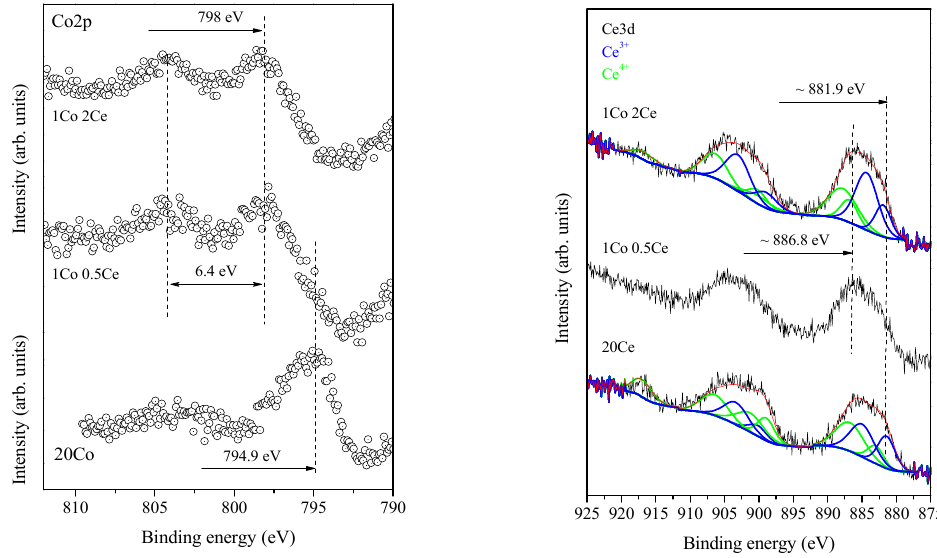
Figure 5. Fitted Co2p1/2 and Ce3d photoelectron peaks of the Co, Ce, and Co–Ce samples.